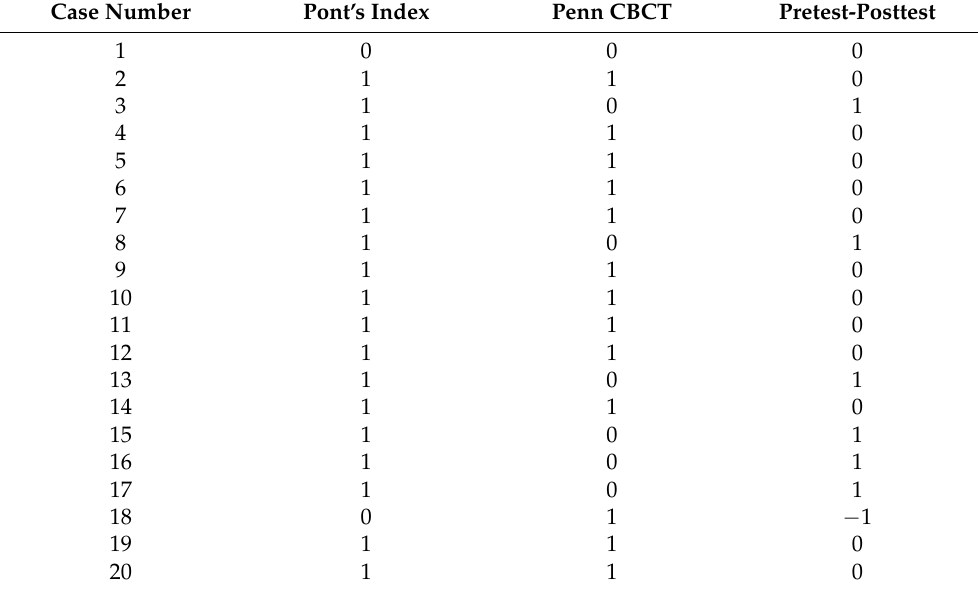
Table 4. McNemar’s